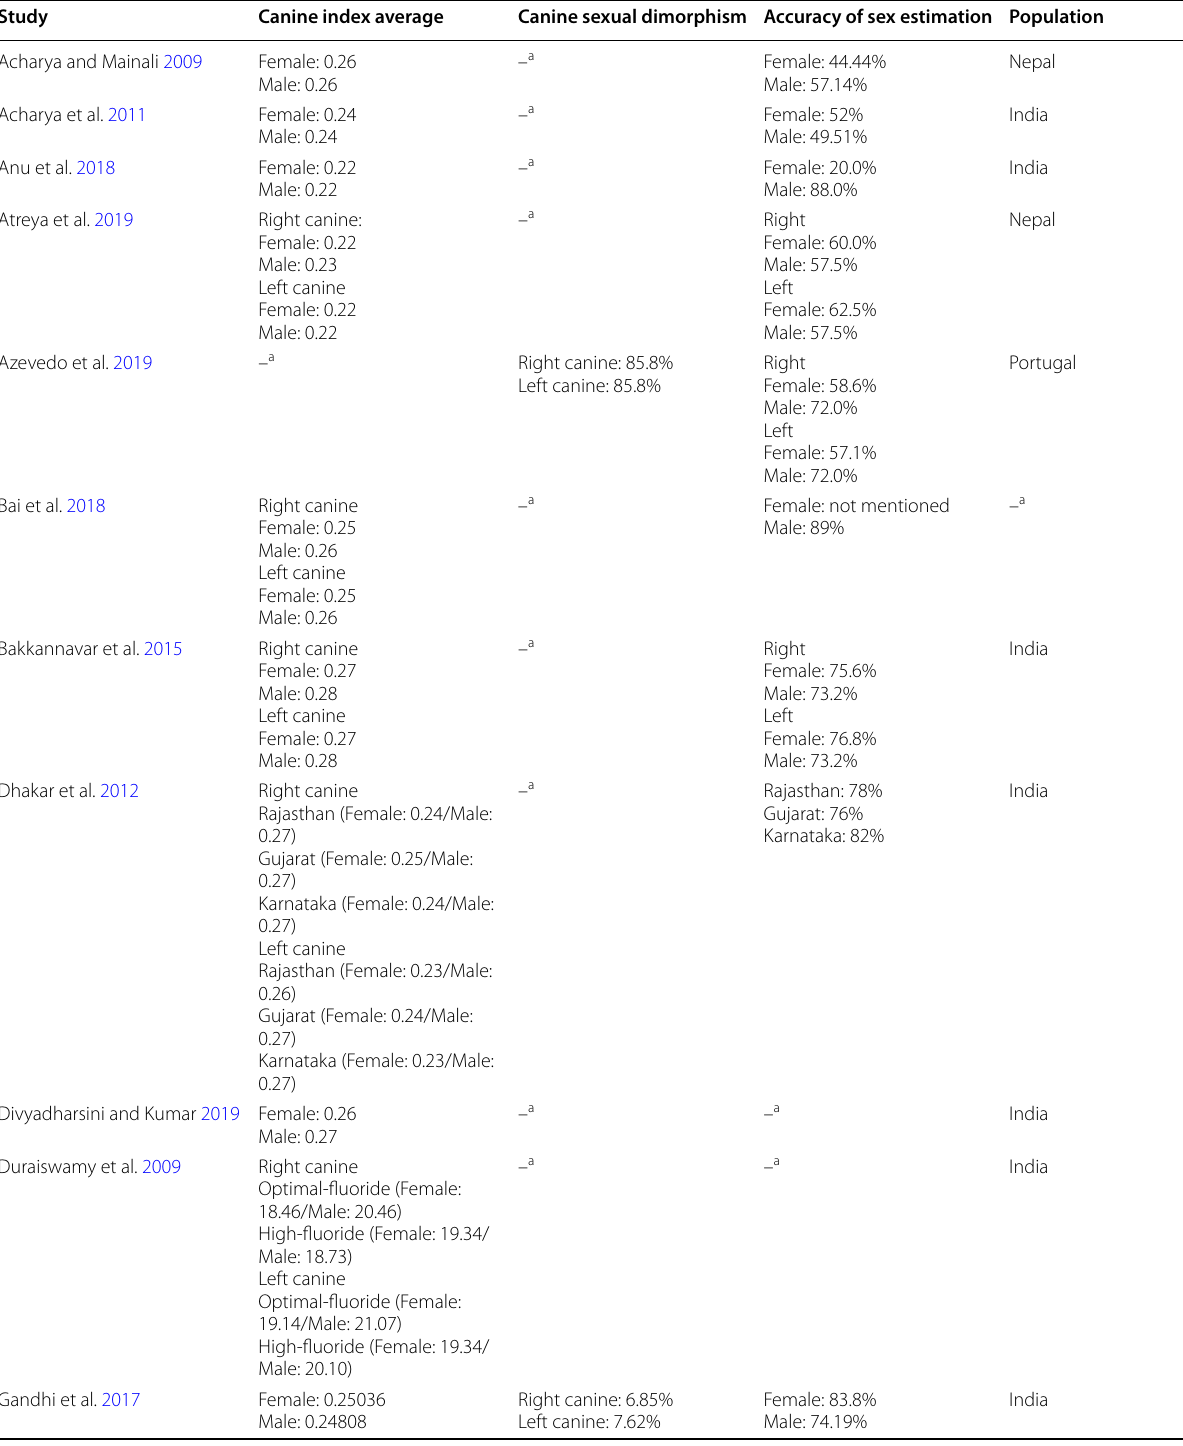
Table 8 Results found by the included